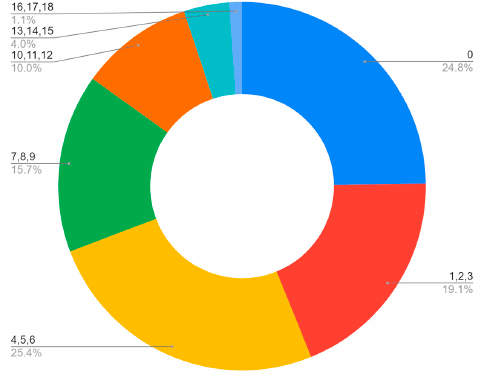
Figure 2. Number of symptoms per person.